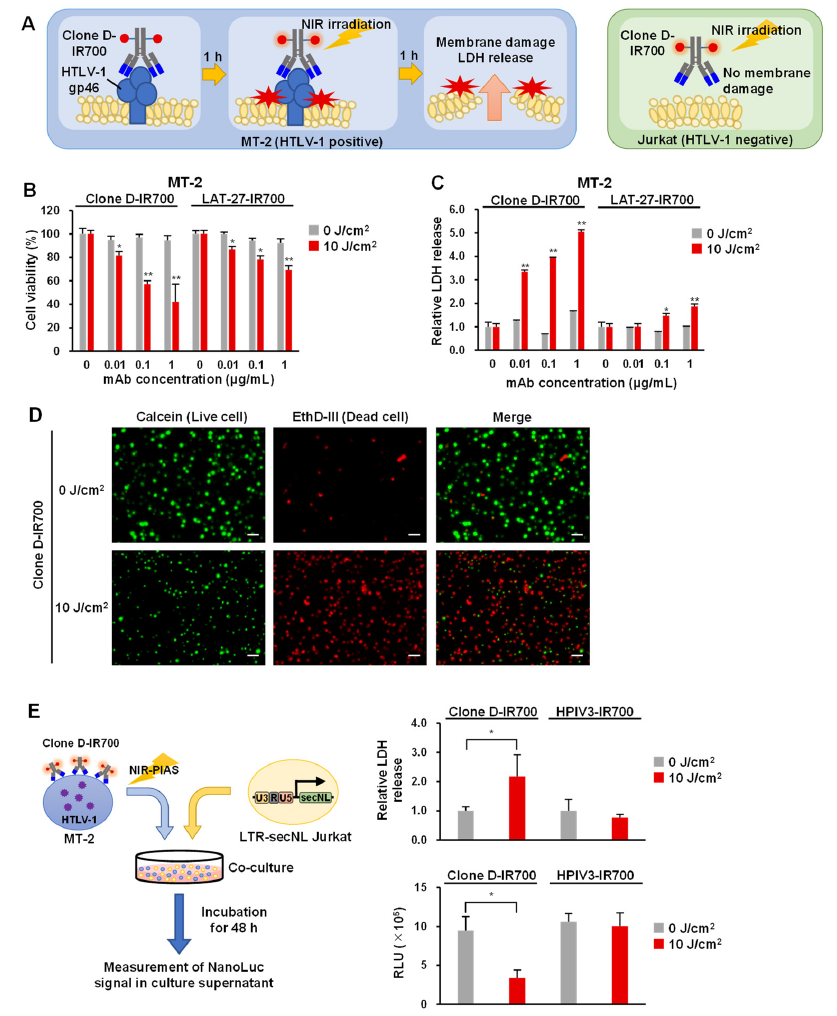
Figure 4. Application of antibodies in NIR-PIAS: ( A ) a schematic of NIR- PIAS, whereby MT-2 cells expressing HTLV-1 Env protein are bound by mAb conjugated IR700, and following NIR light irra- diation, cell membranes become damaged, causing cytotoxicity and cell lysis, which releases cell contents (e.g., LDH). Jurkat cells are not bound by antibodies and show no cytotoxicity after